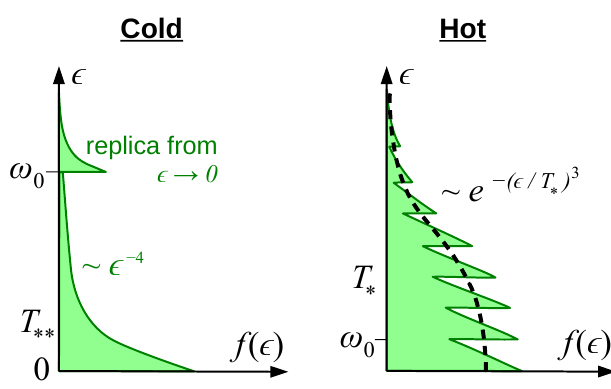
Figure 2: A schematic representation of the quasiparticle distribution function f ( ε ) (green shaded areas) in the two regimes, cold and hot (left and right panels), de- scribed in Secs. 3.1 and 3.2, respectively. For cold quasiparticles, most population is concentrated at energies ε (cid:174) T ∗∗ (cid:28) ω ; above T ∗∗ , the distribution function decays 0 as f ( ε ) ∼ ε − 4 ; f ( ε ) has a second, smaller peak at ε = ω (replicas at higher multi- 0 ples of ω can be neglected). In the hot quasiparticle regime, f ( ε ) has a sawtooth 0 dependence with the period ω , on top of a smooth envelope (black dashed curve), 0 characterized by a scale ε ∼ T ∗ (cid:29) ω . (Note the different scales for ω in the two 0 0